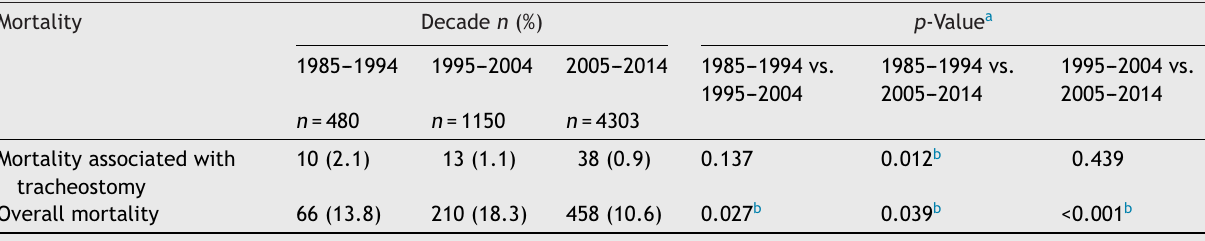
Mortality in children who received a tracheostomy between 1985 and 1994, between 1995 and 2004, and between 2005 and 2014.